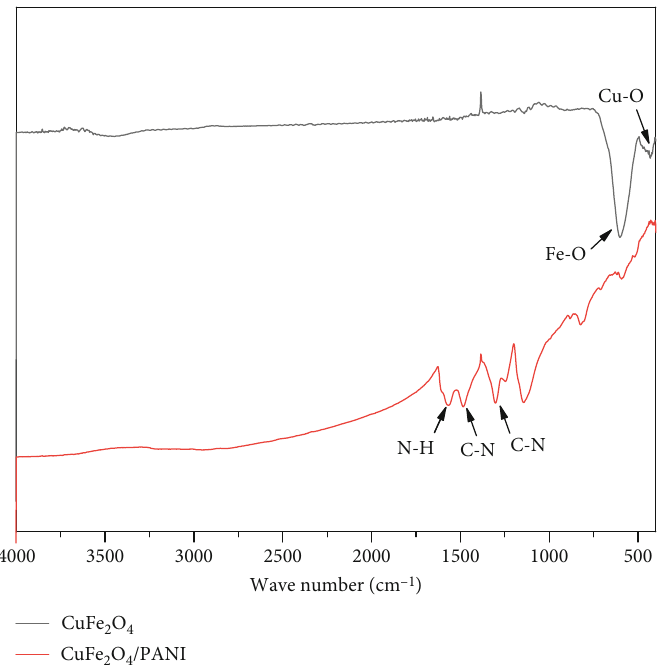
Figure 5: FTIR analysis of CuFe